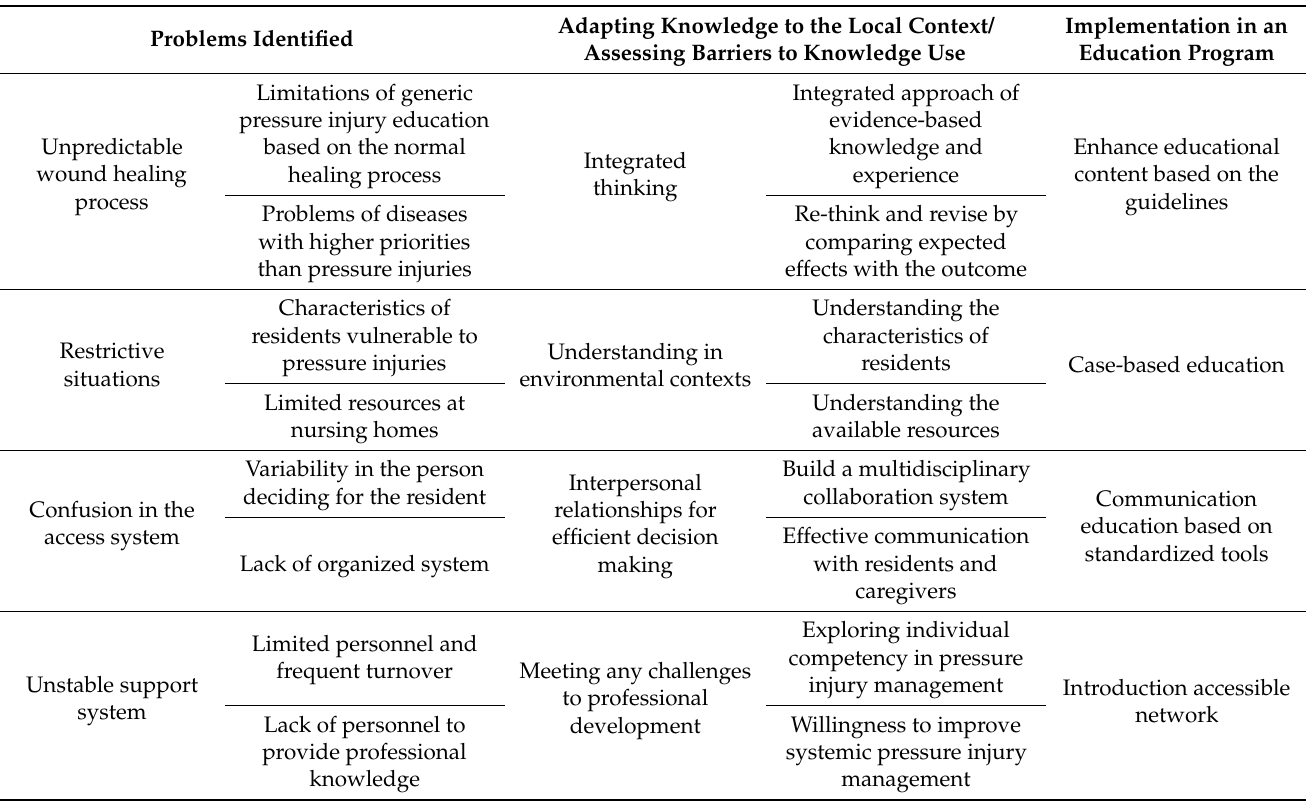
Table 2. Interventions for barriers to integrating an educational